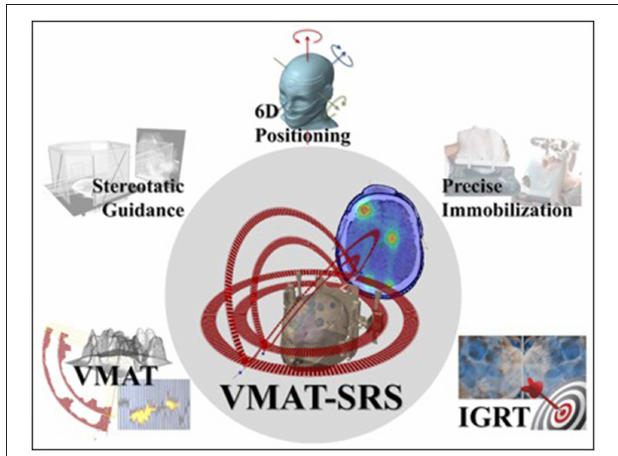
FIGURE 3 | VMAT for multiple-metastasis SRS and the technological tools for its successful clinical